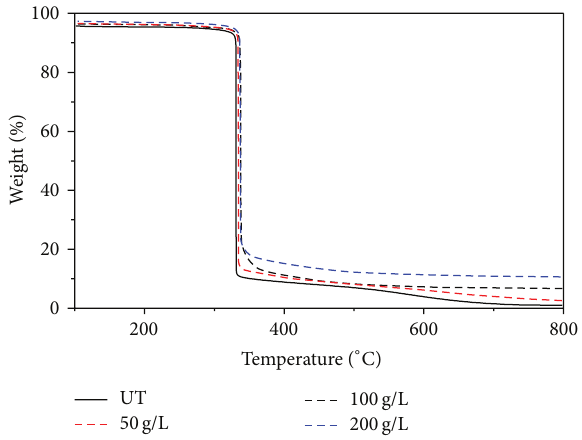
Figure 4: TGA thermograms of untreated and treated CO-2 cotton